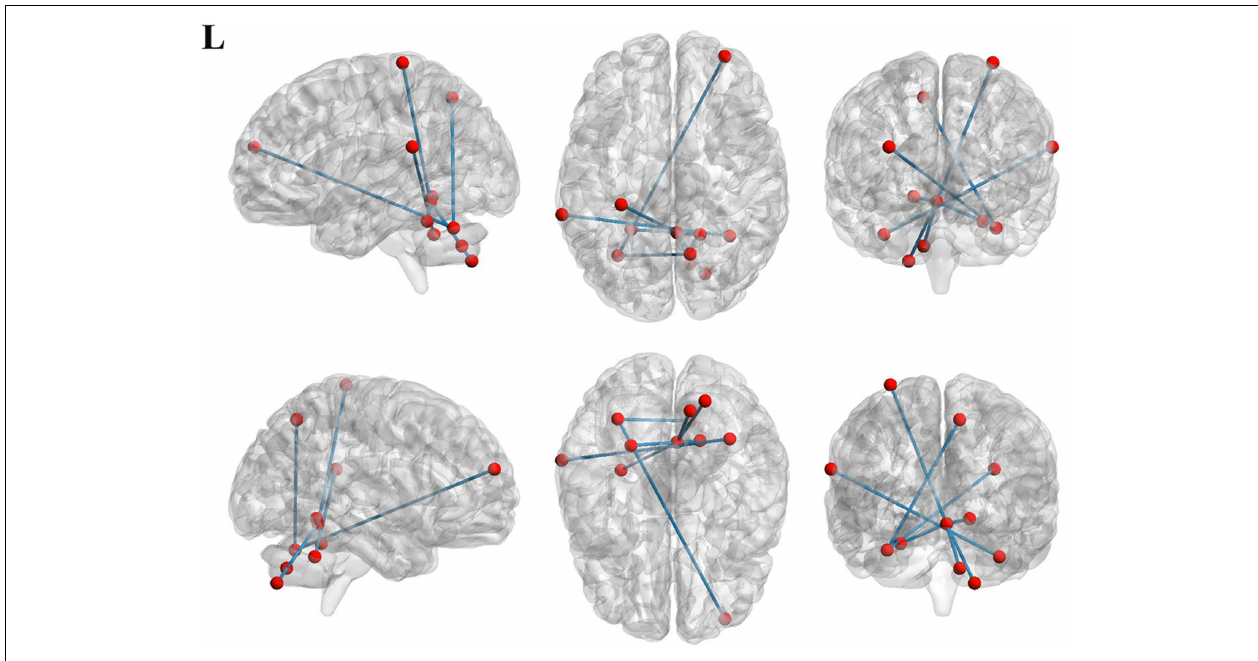
TABLE 3 | Regions of significant different connectivity between MSA-c type and controls. ROIs Brain regions Cluster voxels MNI coordinates (mm) Maximum Z x y